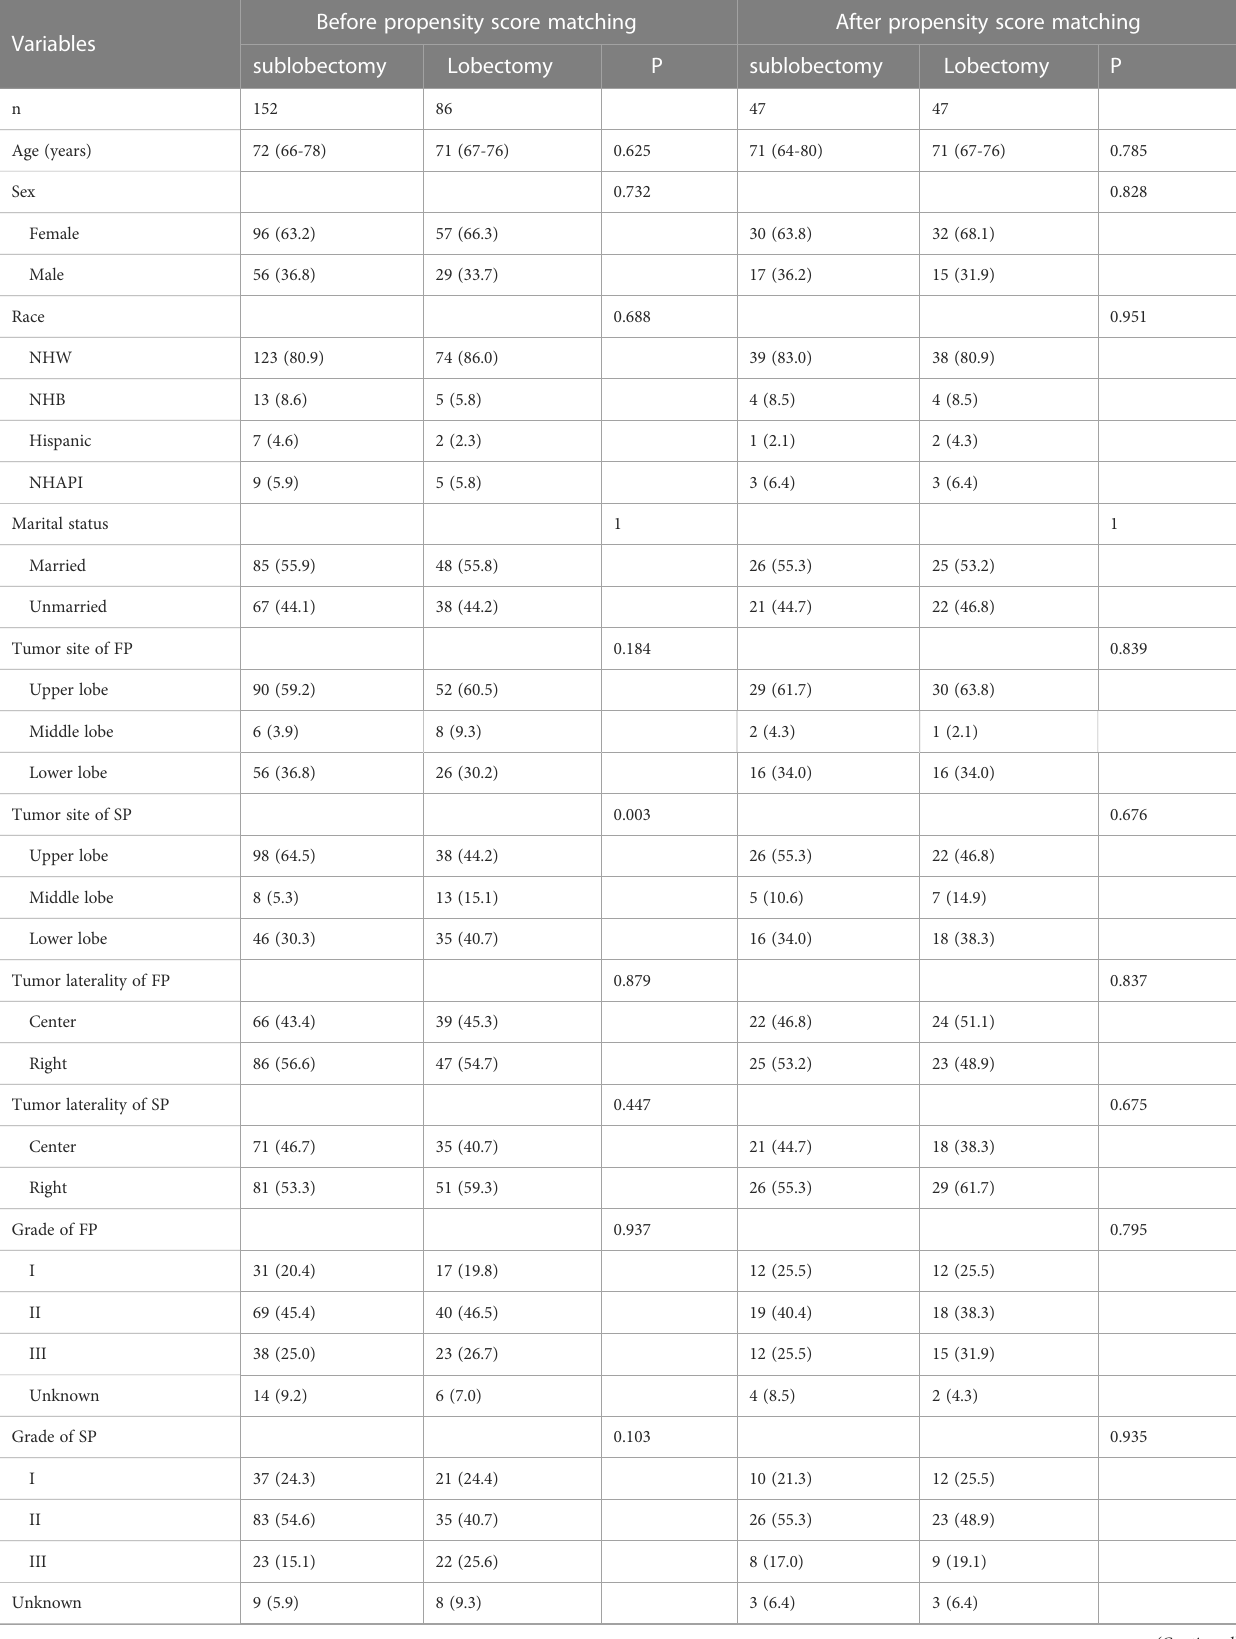
TABLE 2 Baseline characteristics between the stage I SP patients undergoing sublobectomy and patients undergoing lobectomy before and after propensity score matching.